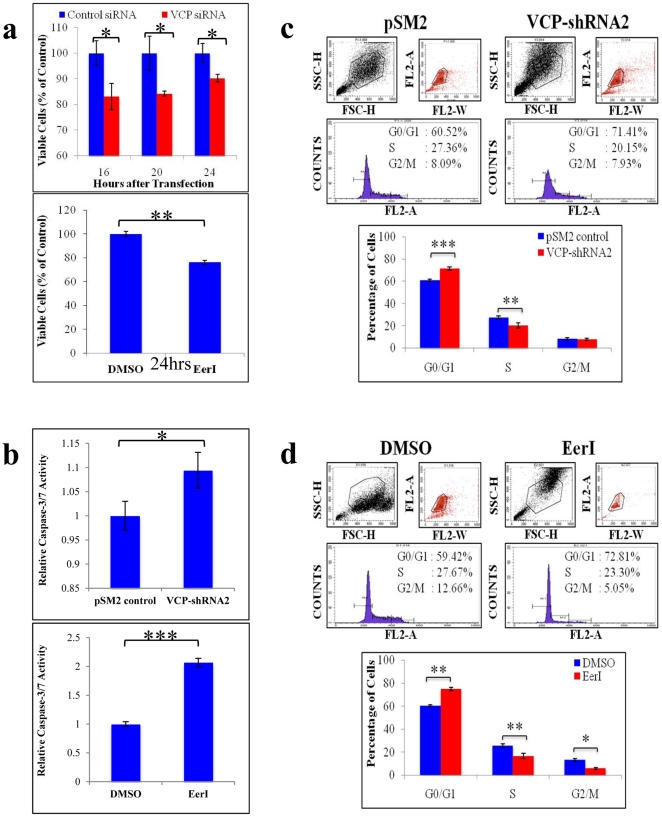
VCP regulates NSCLC proliferation, apoptosis and cell division.(a) H1299 cells were seeded on a 96-well plate and either transfected with pSM2 control vector or VCP-shRNA (for 16 hrs) or treated with EerI (10 µM) or DMSO (vehicle) for 24 hrs. Promega Aqueous One MTS reagent was added to each well, 2 hours before stopping the experiment and VERSAmax microplate reader was used to quantify the MTS activity (n = 4) at indicated time points. Our data shows a significant (p<0.01) decrease in cell proliferation by VCP inhibition. (b) H1299 cells were seeded on a black-bottomed 96-well plate and either transfected with pSM2 control vector or VCP-shRNA or treated with EerI or DMSO. After 48 (VCP-shRNA) or 24 (EerI) hours, caspase-3/7 activity was quantified using the luminescence substrate (Promega). Our data shows an increase in caspase-3/7 activity after transient VCP knockdown (* p<0.05) and a very significant increase (two-fold) in caspase-3/7 activity after treatment with functional inhibitor of VCP, EerI (*** p<0.00001). Next, (c) H1299 cells were either transfected with VCP-shRNA2 and pSM2 control vector or (d) treated with EerI or DMSO. Cells were then fixed in 70% ethanol followed by propidium iodide (10 µg/ml) staining for 1 hour. The profiles of DNA content (measured by a FACScan flow cytometer) for cell-cycle distributions are shown. Our data, summarized in the bar graph (bottom of each panel), shows that VCP knockdown induced G0/G1 arrest (*** p<0.001) and reduced the number of cells undergoing DNA replication (S-phase; ** p<0.01). Inhibition of VCP's function by EerI not only induced G0/G1 arrest (** p<0.01) and decreased DNA replication (** p<0.01) but also significantly reduced the number of cells undergoing mitosis (G2/M-phase; * p<0.05). VCP inhibition controls the tumorigenic capacity of NSCLC by slowing proliferation and division while simultaneously inducing apoptosis.